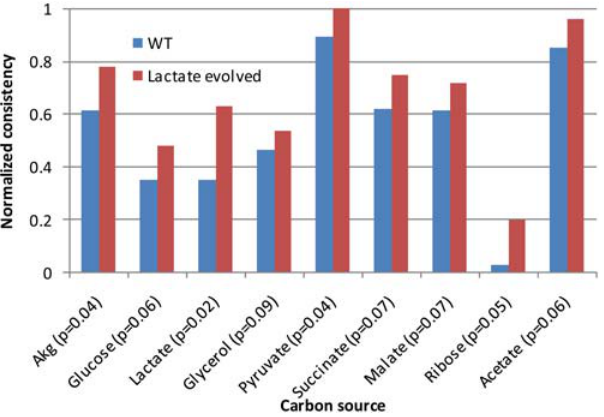
Figure 4. Lactate-evolved strain consistency scores. This figure demonstrates the same result as Figure 3, but with strains evolved on lactate. The normalized consistency scores for growth on each of the tested carbon sources are higher for evolved strains, indicating that the gene expression data from the evolved strains are more consistent with efficient growth on each carbon source.